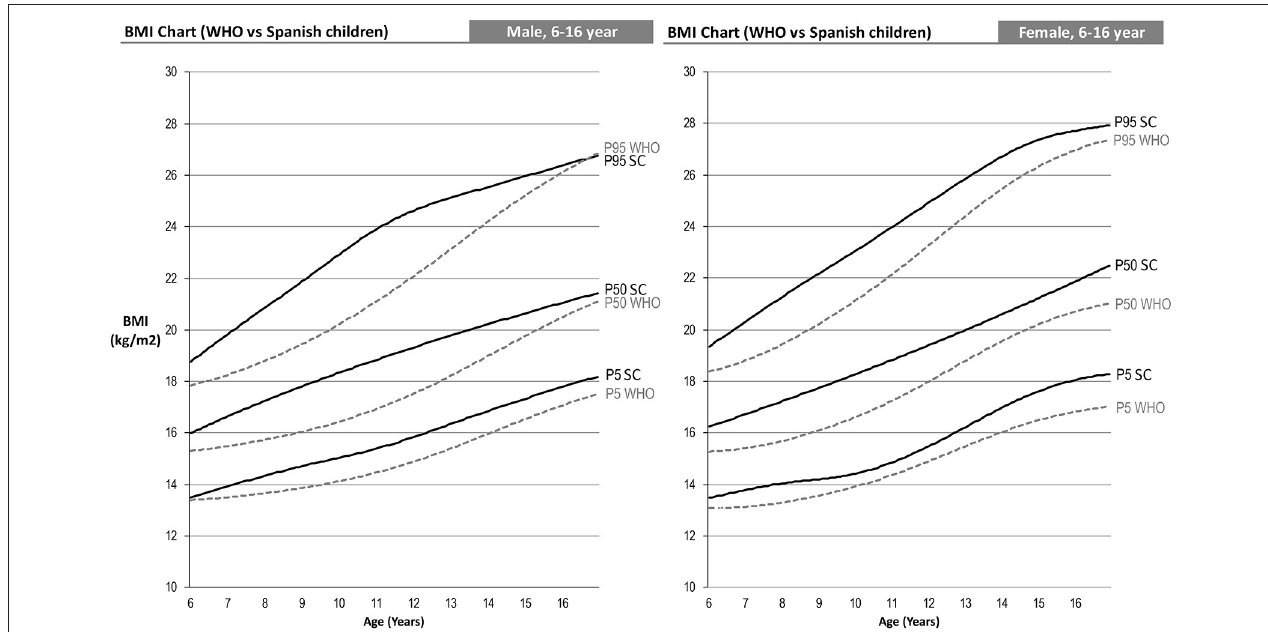
FIGURE 6 | WHO 2007 and Spanish-eastern children BMI percentile comparison. Two-sample Anderson Darling test for goodness of fit of the curves: male 5th percentile (AD: 11.93; p = 0.000); Male 50th percentile (AD: 19.94; p = 0.000); male 95th percentile (AD: 13.50; p = 0.000); female 5th percentile (AD: 7.03; p =